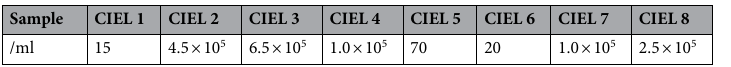
Table 2. The initial inoculation amounts of each strain for high-pressure